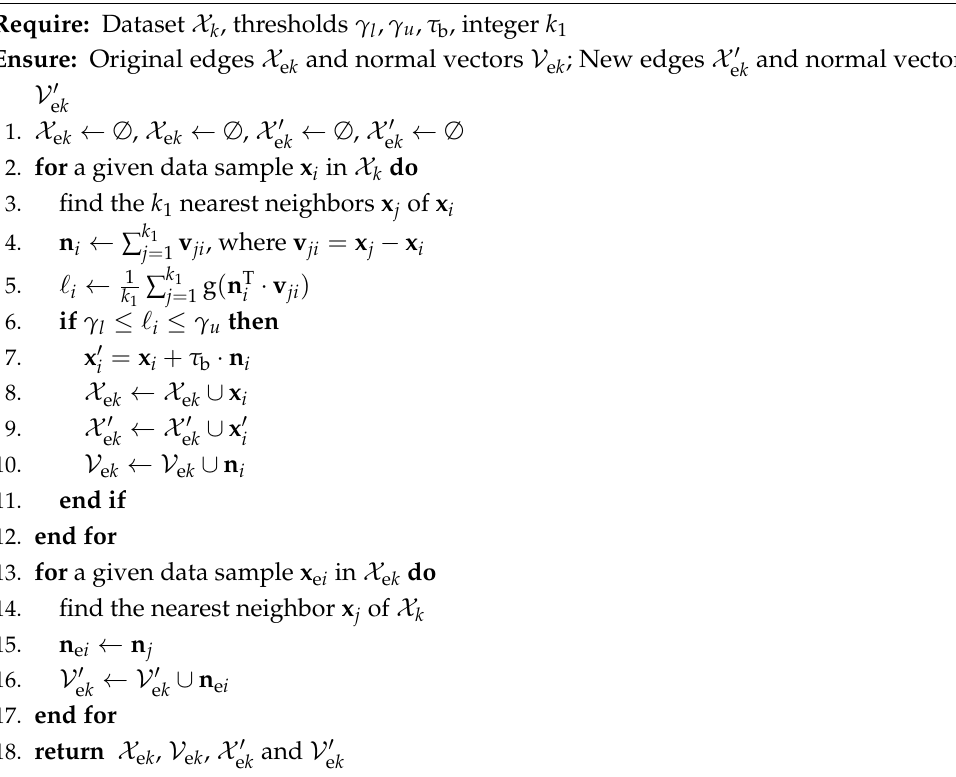
Algorithm 1 Movable Boundary